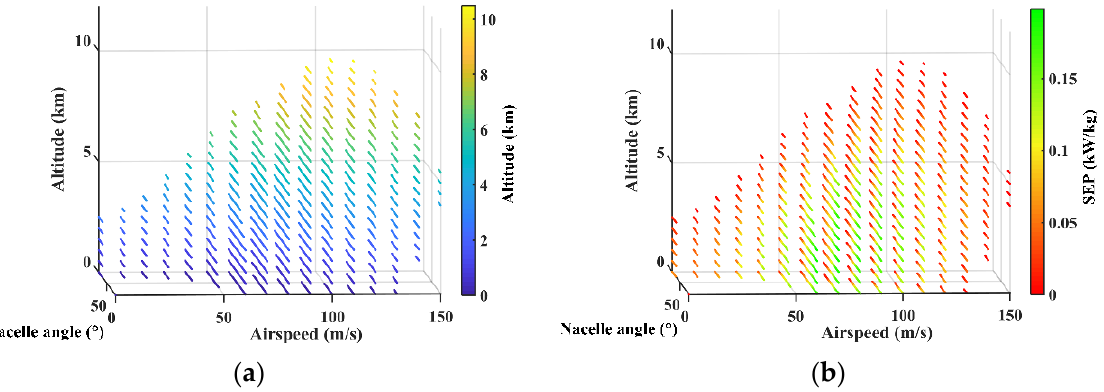
Figure 7. ( a ) Discrete 3D envelope obtained by proposed method; and ( b ) discrete data colored by SEP.